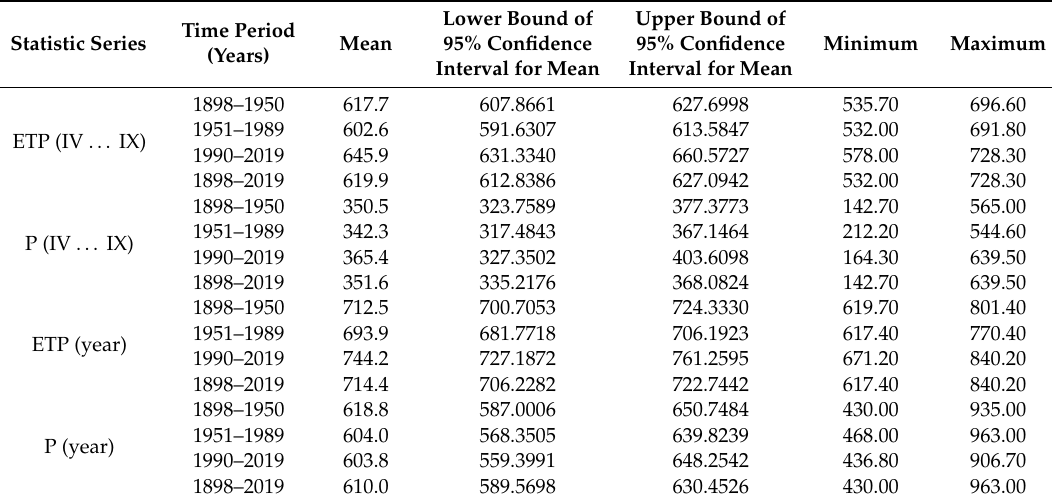
Table 1. Statistical indicators regarding the amount of precipitation (P IV ... IX) and evapotranspiration (ETP IV ... IX), cumulated in April (IV) to September (IX), respectively, relating to the amount of precipitation (P year) and evapotranspiration (ETP year) accumulated at full year level, recorded annually at the Regional Meteorological Center Banat-Crisana, Romania (expressed in mm).